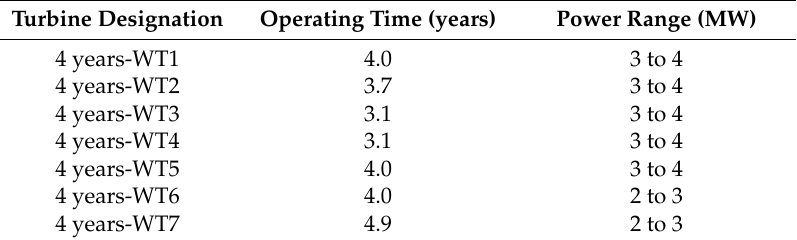
Table 7. Turbine data of the four-year group for trend analysis with PAO I.